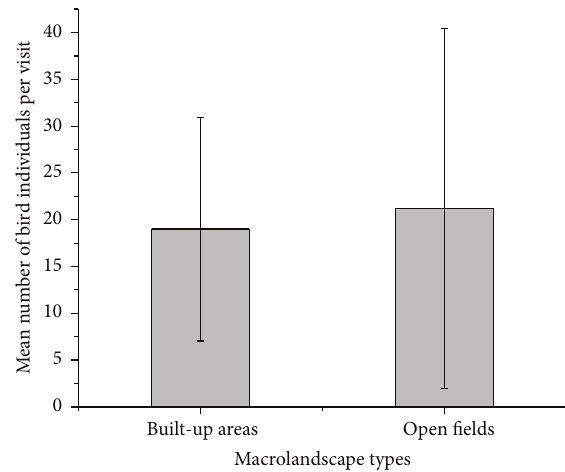
Figure 5: Mean number of bird individuals encountered per visit by macrolandscape type.